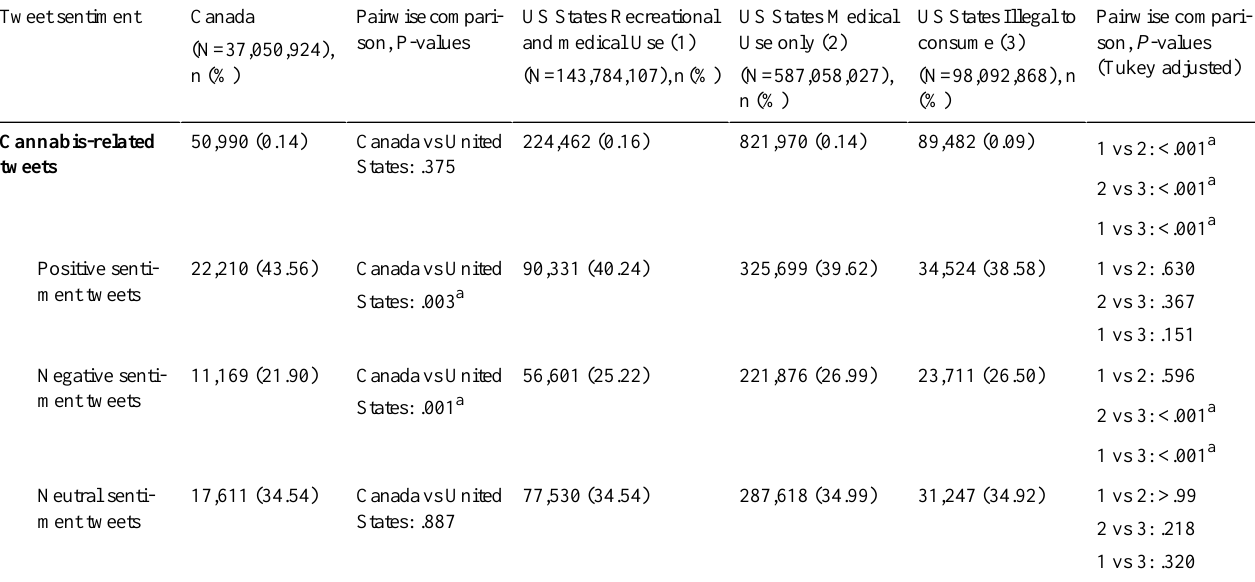
Table 1. Sentiment of cannabis-related tweets in the United States and Canada, January